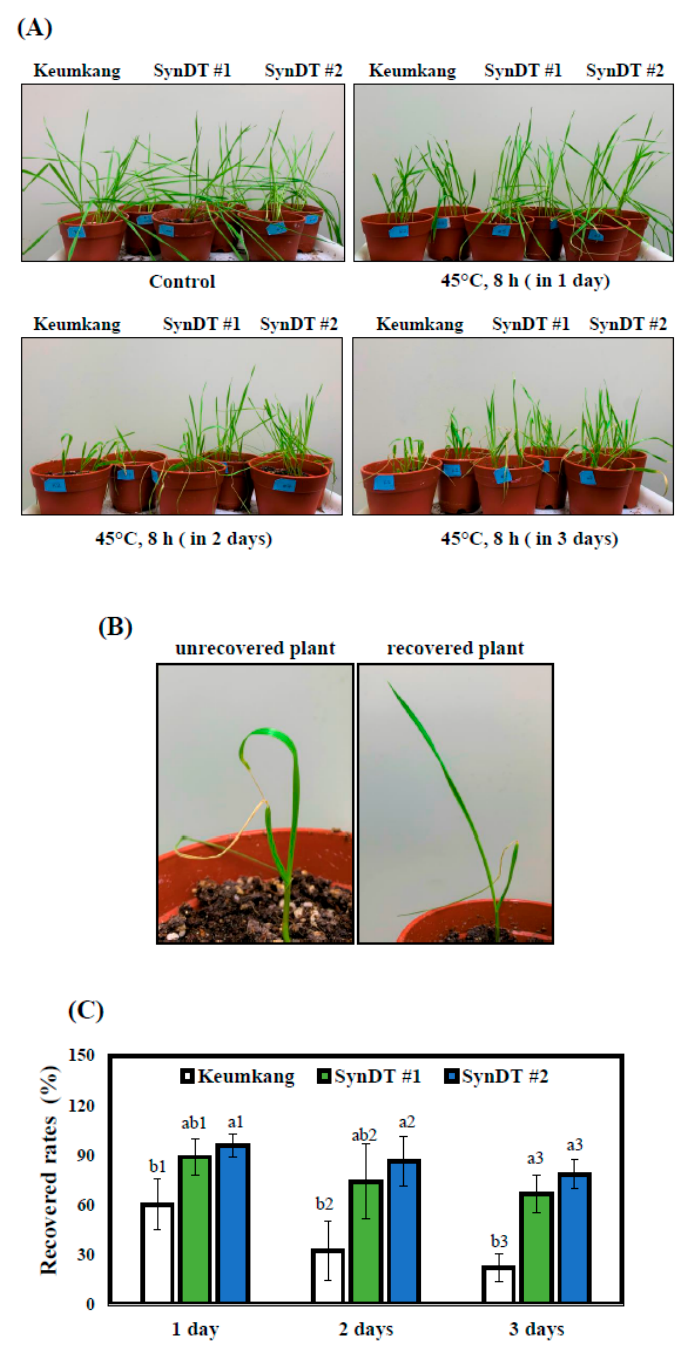
Figure 3. Growth performance of Keumkang and SynDT #1 and #2 in response to HS . ( A ) The phenotype of Keumkang, SynDT #1, and SynDT #2 after 4 days of recovery from HS at 45 °C for 8 h/day. ( B ) The criteria to distinguish between unrecovered and recovered plants from HS. ( C ) The recovery rates of Keumkang, SynDT #1, and SynDT #2. Six-day-old wheat seedlings were exposed to HS at 45 °C for 8 h for 1, 2, or 3 consecutive days. The pictures and quantification data were obtained 4 days after HS treatment. The experiments were conducted at least twice to verify that the results were consistent. Standard deviation value was calculated from three replicates in each treatment. One-way ANOVA and Tukey’s test ( α = 0.05) were performed using SAS. Different letters (a, b, or c) indicate significant differences ( p < 0.05).